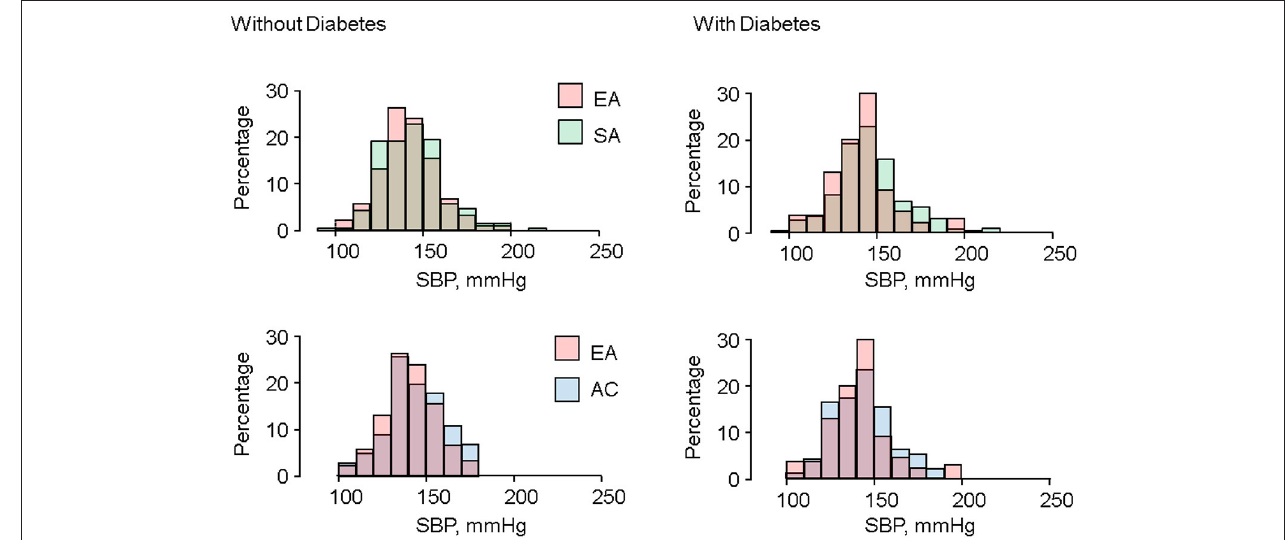
FIGURE 1 | Ethnic differences in distributions of systolic BP in people with and without diabetes.